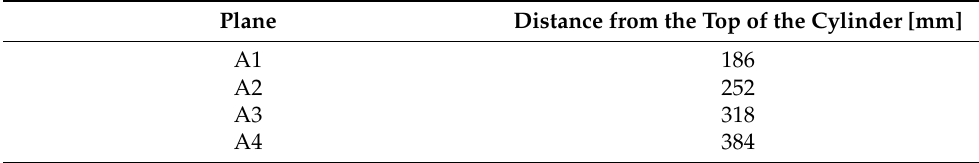
Figure 1. Working chamber of the furnace with cylinder view from the furnace’s door ( a ) and diagram of the furnace: 1—working chamber of the furnace, 2—fan, 3—annular channel, 4—door, 5—heat source, 6—wall of working chamber, 7—cylindrical partition, 8—cylinder with marked measuring planes A1–A4 and the gas flow direction ( b ). Table 1. Location of planes A1–A4 along the cylinder length.